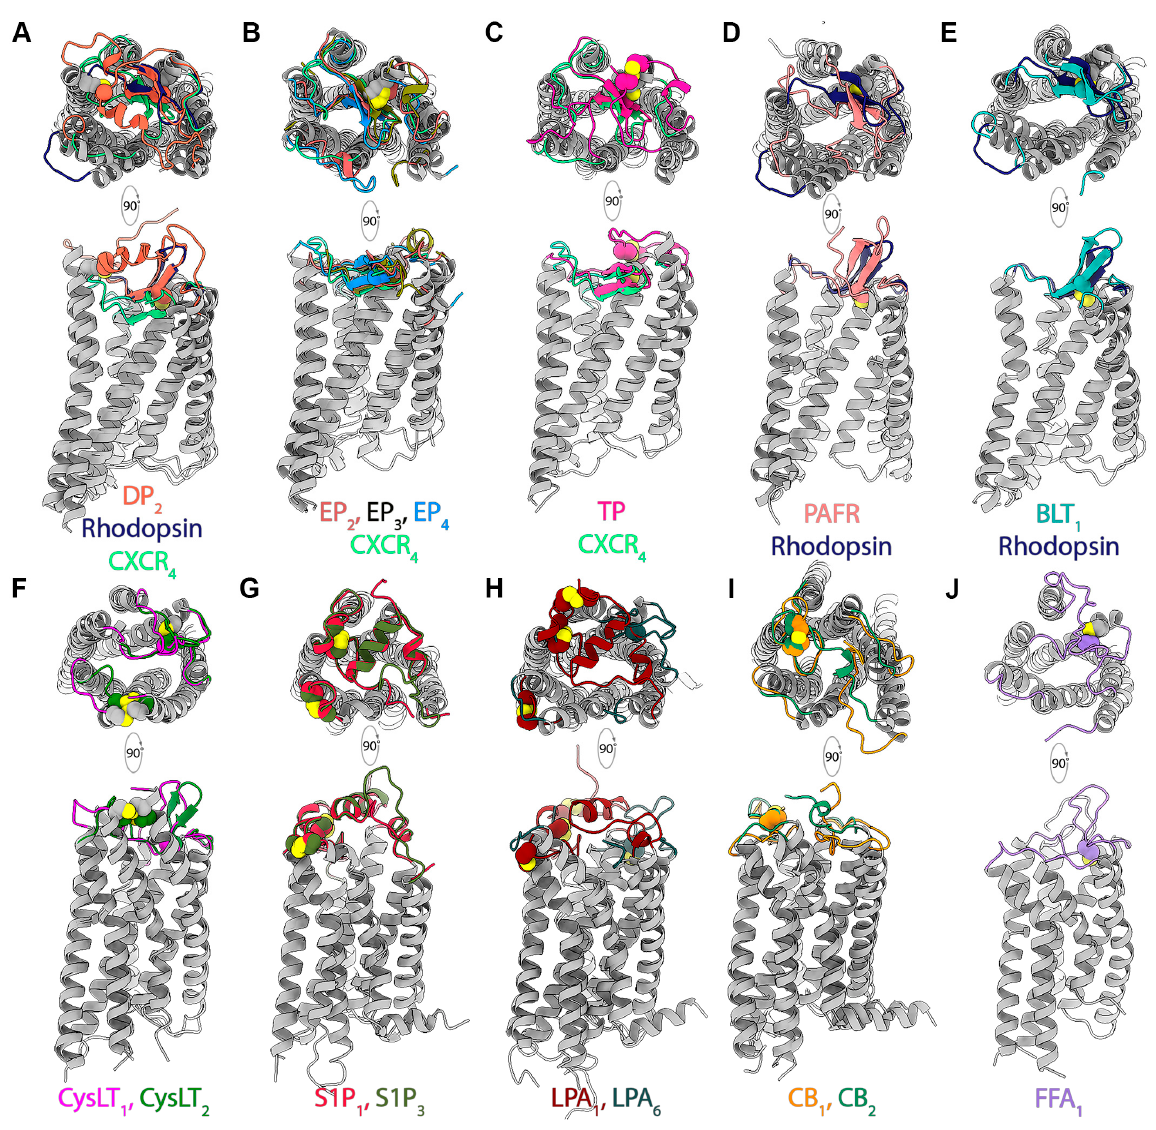
Figure 3. Organization of the extracellular domain in representative lipid receptor structures belonging to ( A ) DP 2 (dark orange), ( B ) EP 2,3,4 (red, olive, blue, respectively), ( C ) TXA 2 (dark pink), ( D ) PAFR (coral), ( E ) BLT 1 (cyan), ( F ) cysLT 1,2 (magenta, dark green, respectively), ( G ) S1P 1,3 (crimson, olive green, respectively), ( H ) LPA 1,6 (maroon, slate, respectively), ( I ) CB 1,2 (orange, sea green), and ( J ) FFA 1 (purple). The structures of rhodopsin (navy blue; PDB ID: 4ZWJ) and CXCR4 receptors (spring green; PDB ID: 3ODU) are superposed with the lipid receptors, where appropriate, to indicate the relative positions of ECL2. The cysteine residues from the lipid receptors involved in disulfide bridges are highlighted using sphere representation.